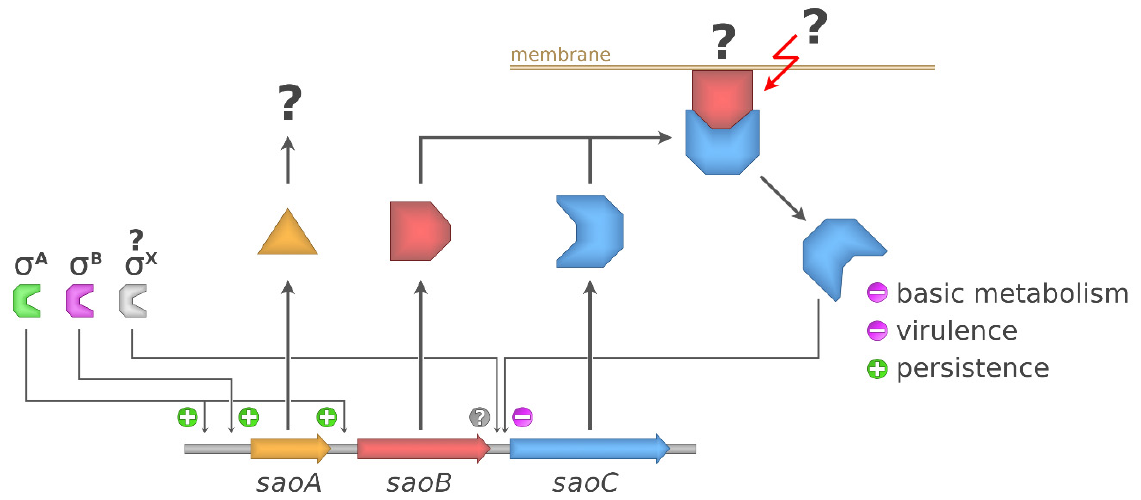
Figure 9. Possible regulatory pathways governing functions of saoABC operon. Promoter sequences of saoABC operon, next to constitutive promoters for σ A , contain also one for σ B . The latter likely increases transcription in stress conditions, not to turn on the SaoC-related system but in order to regenerate SaoA and SaoB proteins and deactivate released SaoC. Functional links between saoABC operon and other, yet uncharacterised, regulatory systems may exist, which is indicated by the pres- ence of conserved but unknown sequence motifs upstream of saoC . It is highly likely that SaoC is a transcription repressor that autoregulates the transcription of its own gene in a negative feedback loop. SaoC is engaged in regulation of the expression of genes related to basic and mostly protein metabolism, but also of genes of virulence factors. The general result of its action seems to be meta- bolic suppression, virulence attenuation and persister formation. SaoB is highly likely an antagonist of SaoC, and might be a membrane-attached protein that keeps SaoC inactive in a membrane-bound state. Functions of SaoA still remain unknown. The role of SaoA and the nature of SaoB, as well as molecular mechanisms underlying interactions among them and SaoC, are yet to be determined. 4. Materials and Methods Plasmids and primers used in the study . For protein expression purposes, the fol- lowing plasmids were used: pETDuet-1 (Novagen, Darmstadt, Germany), pGEX-5T [47], pCN35, pCN51 and pCN68 [48]. Plasmid constructs, unless otherwise described, were ob- tained either by the common restriction cloning protocol or ligase independent cloning. All the plasmid constructs and primers used in the study are described in detail in Sup- plementary Table S1. Restriction cloning PCR products were obtained using RUN DNA Polymerase (A&A Biotechnology, Gdynia, Poland), purified with Clean-Up Concentrator (A&A Biotechnology, Gdynia, Poland) and digested with respective enzymes (Thermo Scientific, Waltham, MA, USA). Plasmids were isolated and purified from Escherichia coli TOP10 (Invitrogen, Waltham, MA, USA) with Plasmid Mini (A&A Biotechnology, Gdy- nia, Poland). Upon digestion and electrophoresis, DNA fragments were incised and iso- lated from agarose gel using Gel-Out Concentrator (A&A Biotechnology, Gdynia, Po- land)and ligated using T4 DNA Ligase (Thermo Scientific, Waltham, MA, USA). All pro- cedures were carried out in accordance with the recommendations of the manufacturers. For ligase independent cloning, Phanta Max Super-Fidelity DNA Polymerase (Vazyme, Nanjing, China) was used both to obtain a gel-purified PCR product of the insert, and to carry out the second PCR reaction with the product (megaprimer) and the target plasmid as described by Van Den Ent and Löwe [49]. Data analysis and visualisation . Graphical representations of sequence motifs and sequence conservation were prepared in CLC Main Workbench (ver. 21.0.3, CLC Bio, Aar- chus, Denmark). Data processing and statistical analysis, if not otherwise indicated, as well as data plots were prepared in Jupyter Notebook application (ver. 4.7.1) using in-house Python (ver. 3.8.5) scripts utilising Matplotlib (ver. 3.2.2), Pandas (ver. 1.1.4),